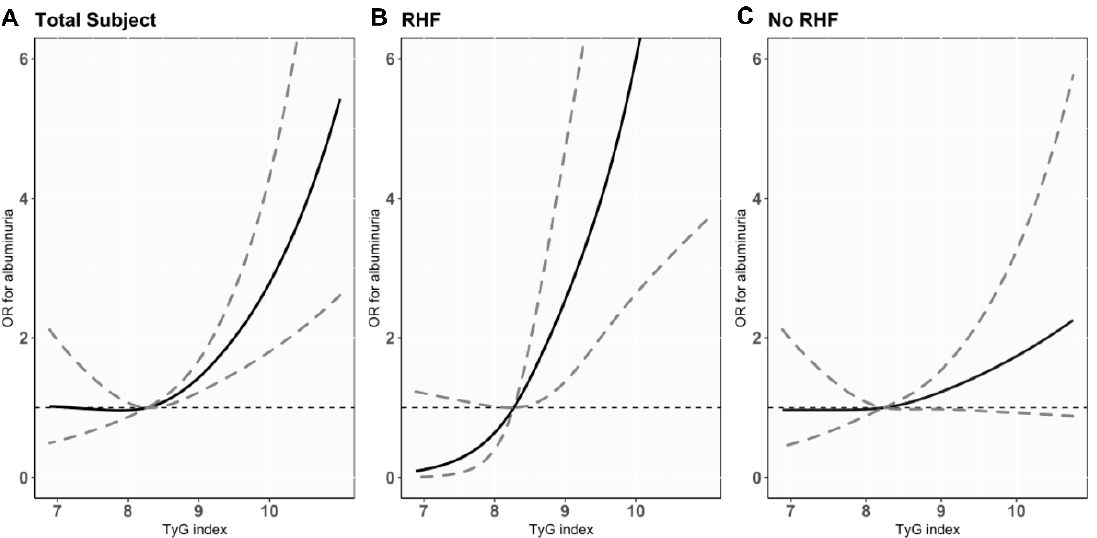
Table 2. Logistic regression analyses for albuminuria according to TyG index.